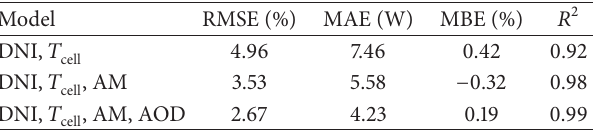
Table 4: Root mean square error (RMSE), mean absolute error (MAE), mean bias error (MBE), and determination coefficient ( 𝑅 2 ) obtained for the three models described in Section